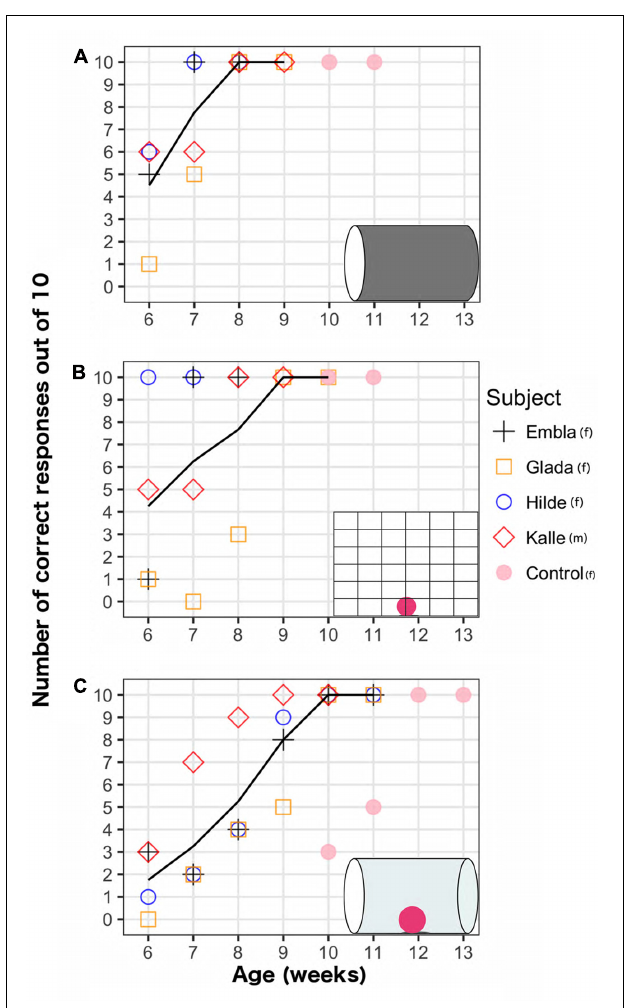
FIGURE 2 | Weekly performance of five raven chicks on three detour tasks (shown in insets): (A) Opaque cylinder task (B) Mesh barrier task (C) Transparent cylinder task. Lines show average scores across weeks for four subjects that began testing on week 6, excluding the control bird that began testing on week